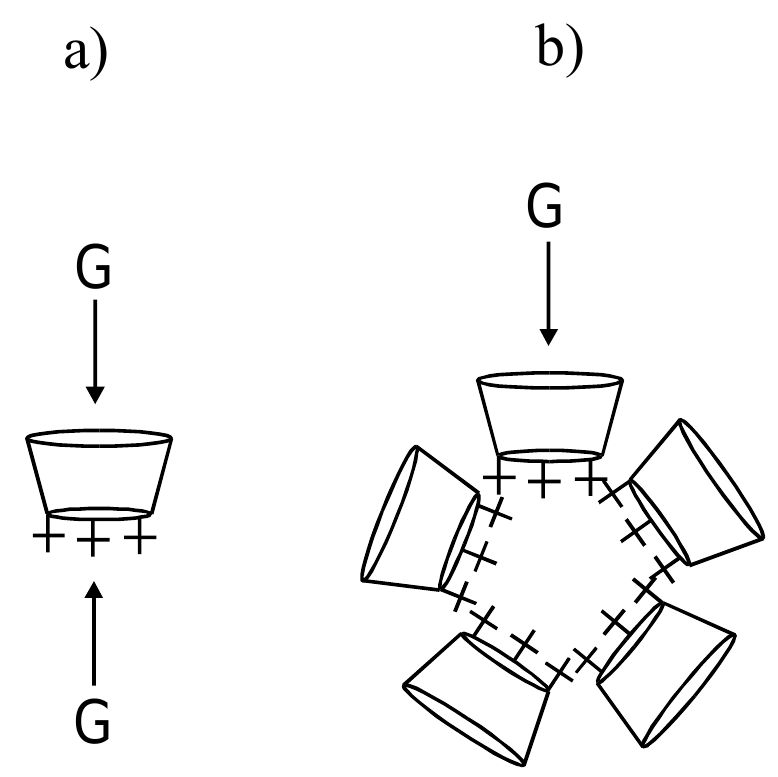
Fig. 3. Scheme of accessibility of TB- α -CD’s cavity under [a)] and over [b)] CMC; G is guest